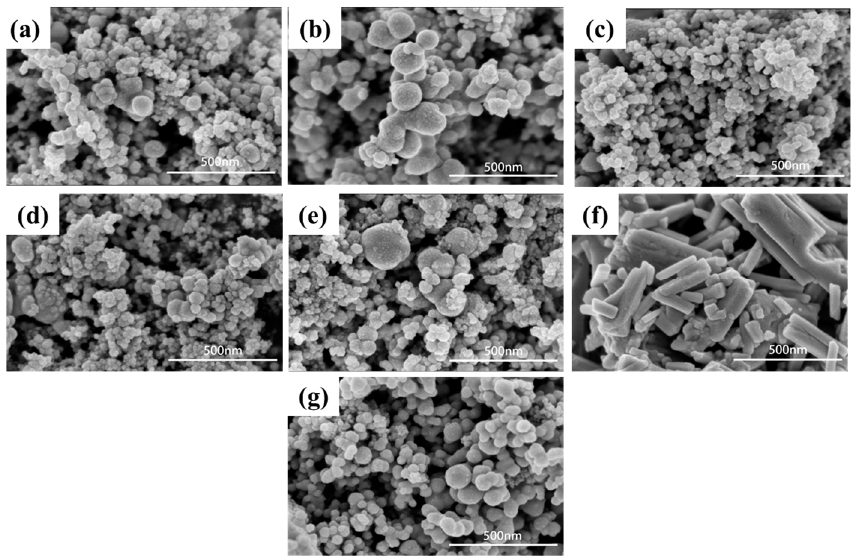
Figure 2. SEM patterns of Ag 2 WO 4 -modified Ag 6 Si 2 O 7 with different mole ratios: ( a ) 2%, ( b ) 3%, ( c ) 4%, ( d ) 5%, ( e ) 6%), and pure ( f ) Ag 2 WO 4 and ( g ) Ag 6 Si 2 O 7